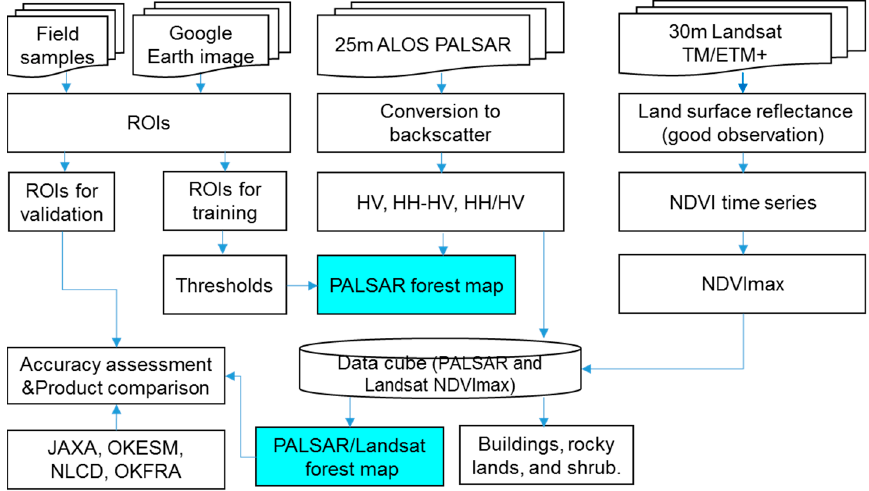
Figure 3. The workflow of forest mapping based on the ALOS PALSAR and Landsat TM/ETM+